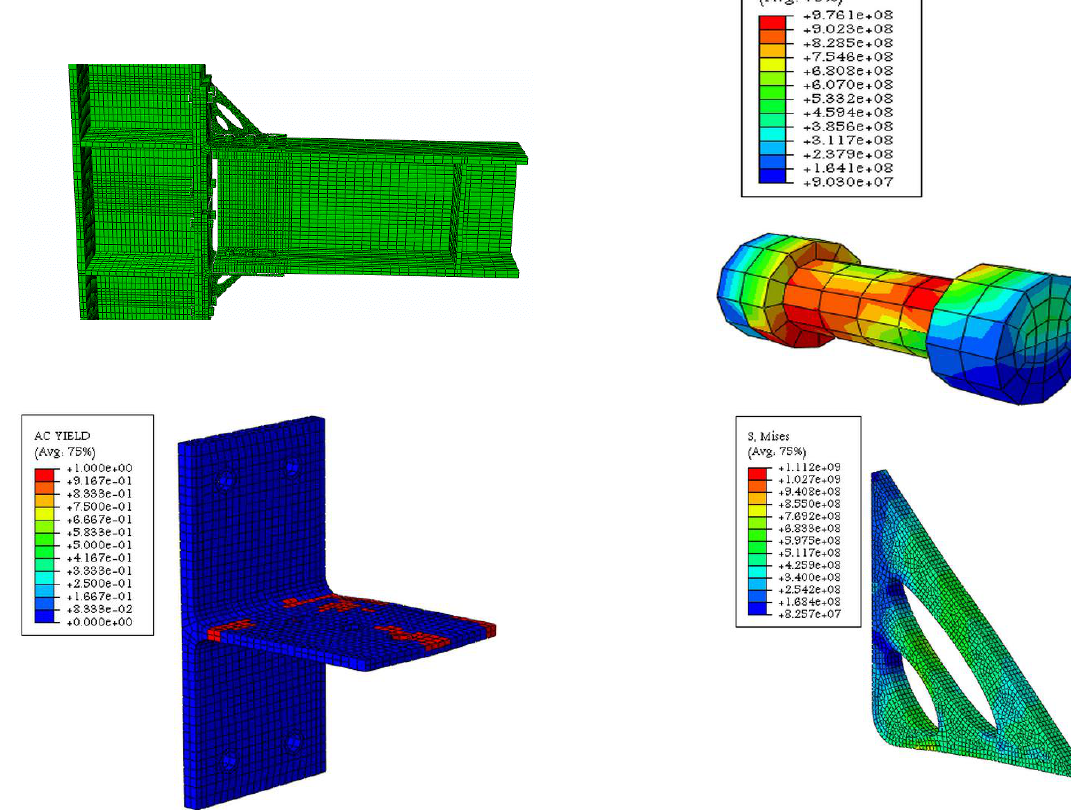
Figure 17. Distribution of Von Mises and AC yield (MPa) for the SP32 model.